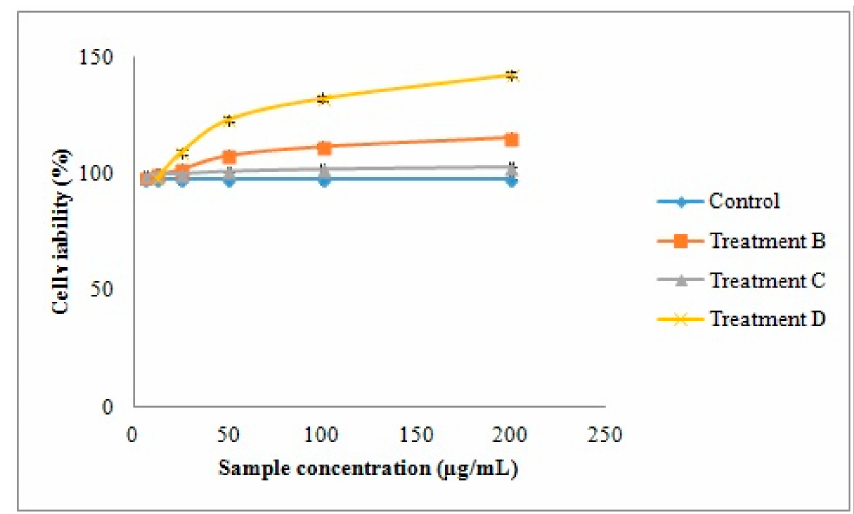
Figure 7. The effect of NVH suspension ( B ), blank chitosomal formulation ( C ) and NVH-loaded chitosomal formulation F6 ( D ) on the proliferation of HDFa cells by MTT assay.